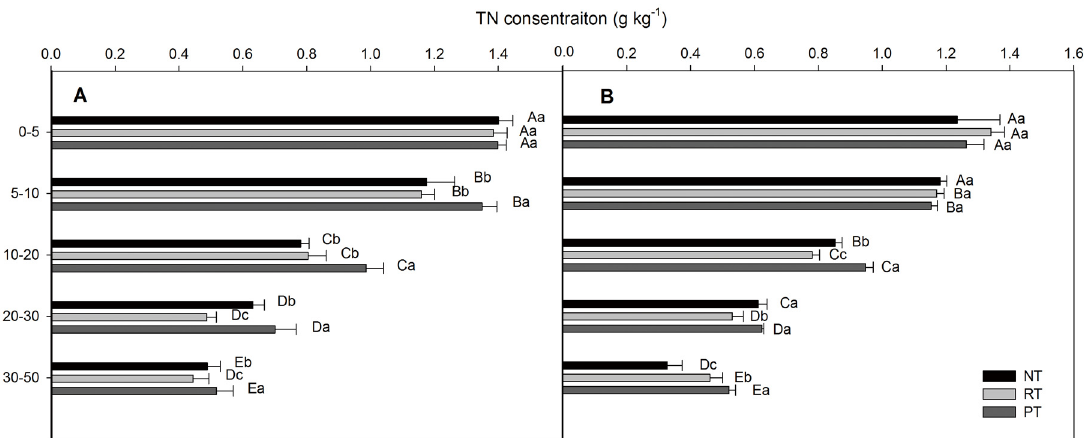
Fig 3. Depth distribution of the soil total nitrogen (TN) concentration under different tillage practices. No till (NT), rotary tillage (RT), and plow tillage (PT): (A) after the maize harvest and (B) after the wheat harvest. The data are presented as the means ± SD (n = 3). The various capital letters indicate significant differences among the soil depths, and the lowercase letters indicate significant differences among the treatments ( P <